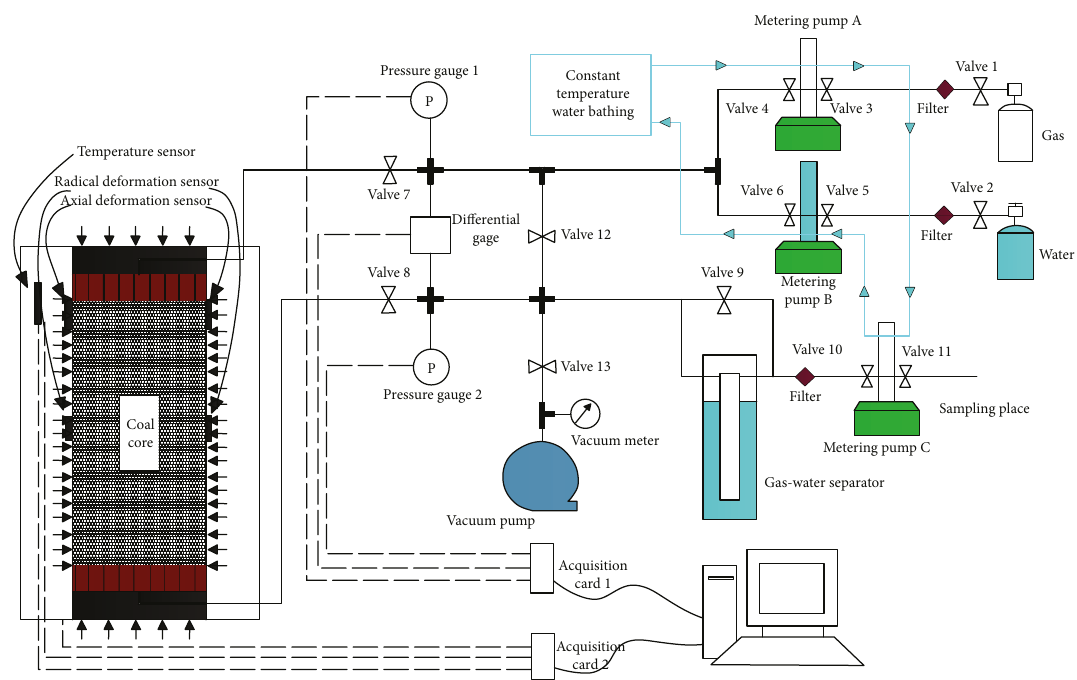
Figure 3: Working principle of mixed gas displacement testing